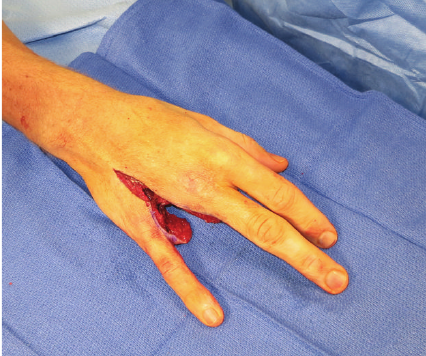
Figure 4: Persistent necrotizing soft tissue infection resulting in a ray amputation. Approximately one month following the second surgery, he presented to clinic with persistent swelling, erythema, induration, and dark necrotic appearing tissue along the base of the affected finger, consistent with persistent necrotizing soft tissue infection secondary to mycobacterial involvement. Ray amputation of the right ring finger was performed, and tissue pathology was consistent with granulomatous inflammation and necrosis, indicating a necrotizing soft tissue infection. Oral moxifloxacin and clarithromycin were continued to complete 6 months of therapy. During this time, he had marked clinical improvement and no evidence of persistent necrotizing soft tissue